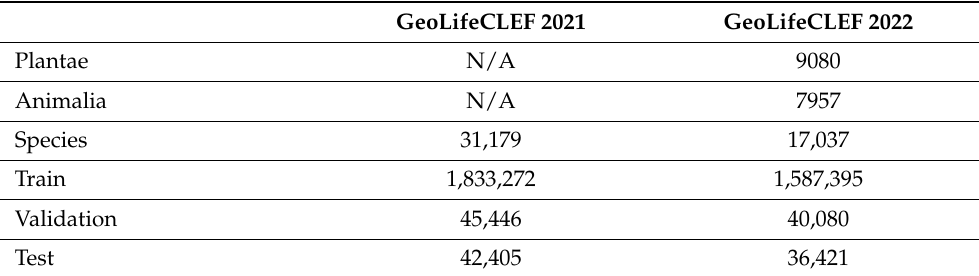
Table 2. The sample statistics of GeoLifeCLEF 2021 and 2022.